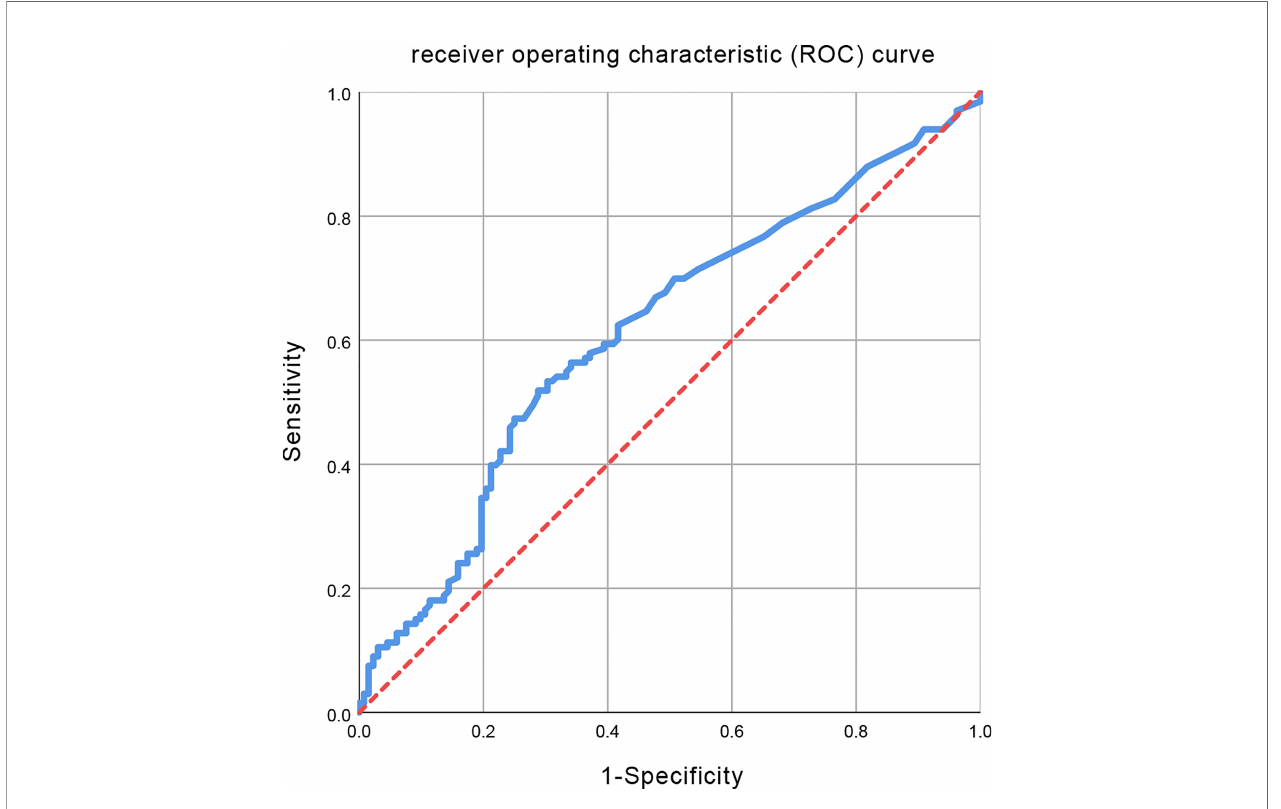
FIGURE 2 | Receiver operating characteristic (ROC) curve for all initiation time of radiotherapy. The area under the curve (AUC) was